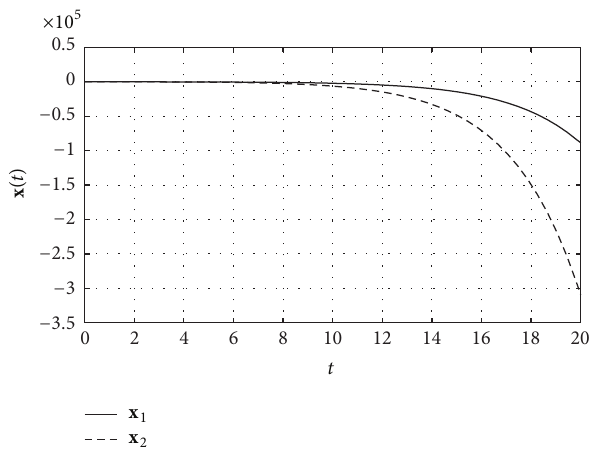
Figure 1: The trajectories of open-loop controlled system state x (𝑡) .